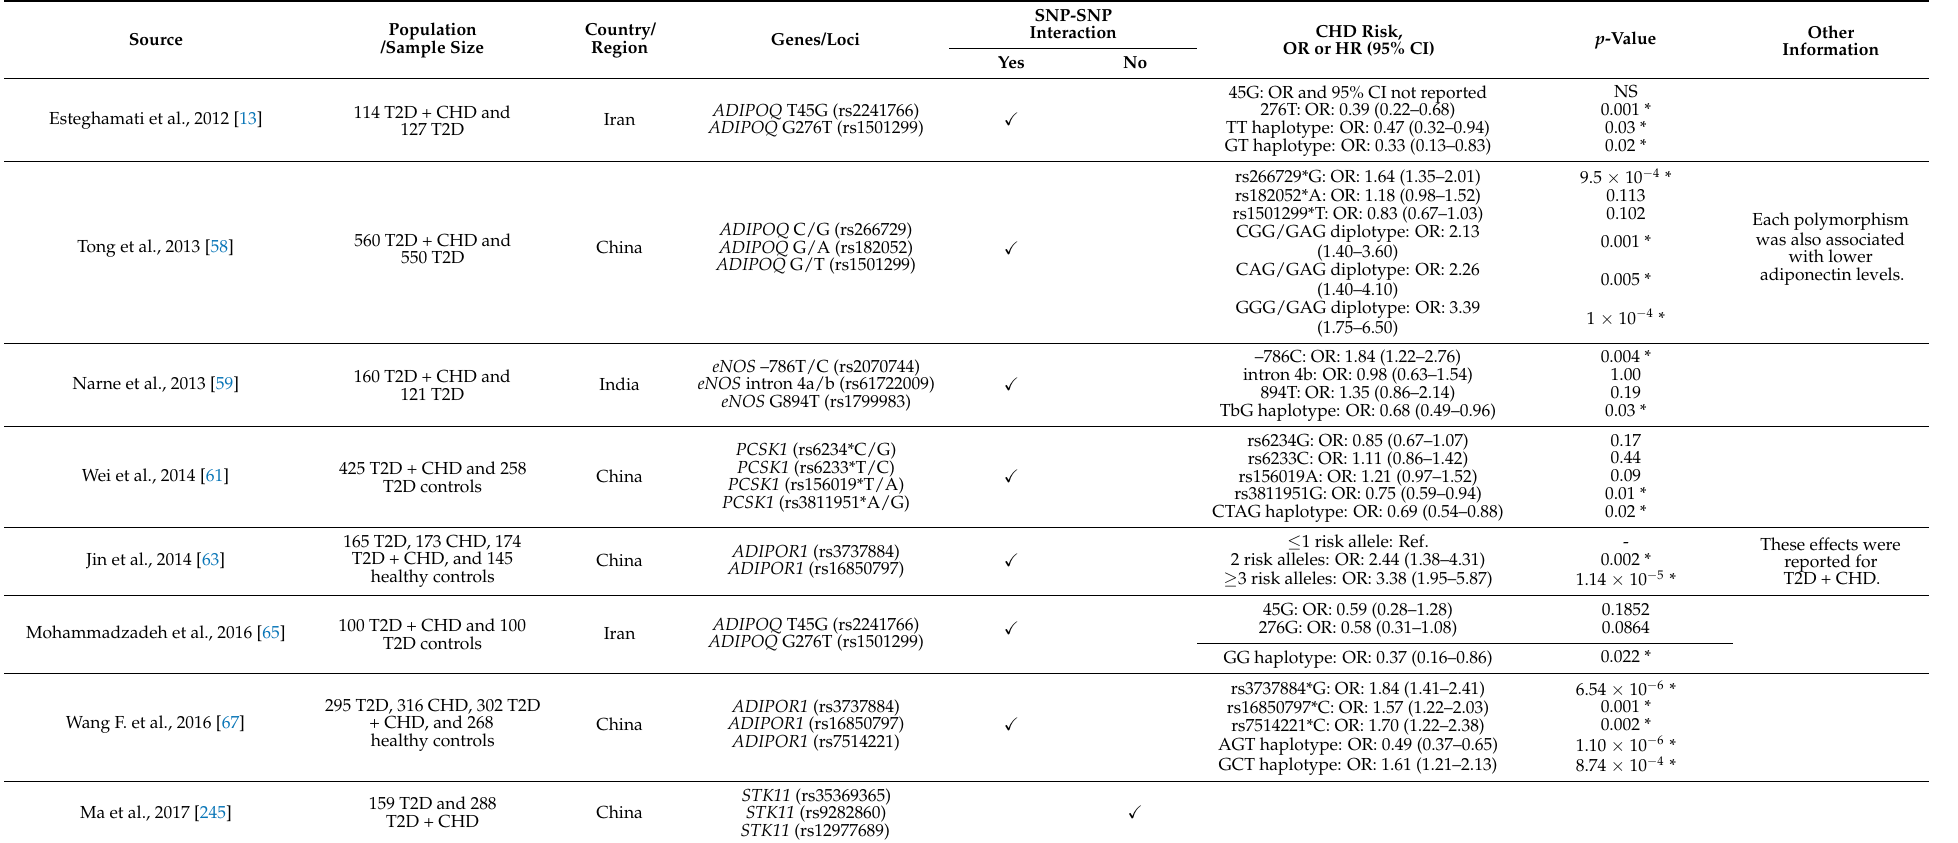
Table 3. SNP–SNP interactions in a single gene and their associations with CHD in T2D